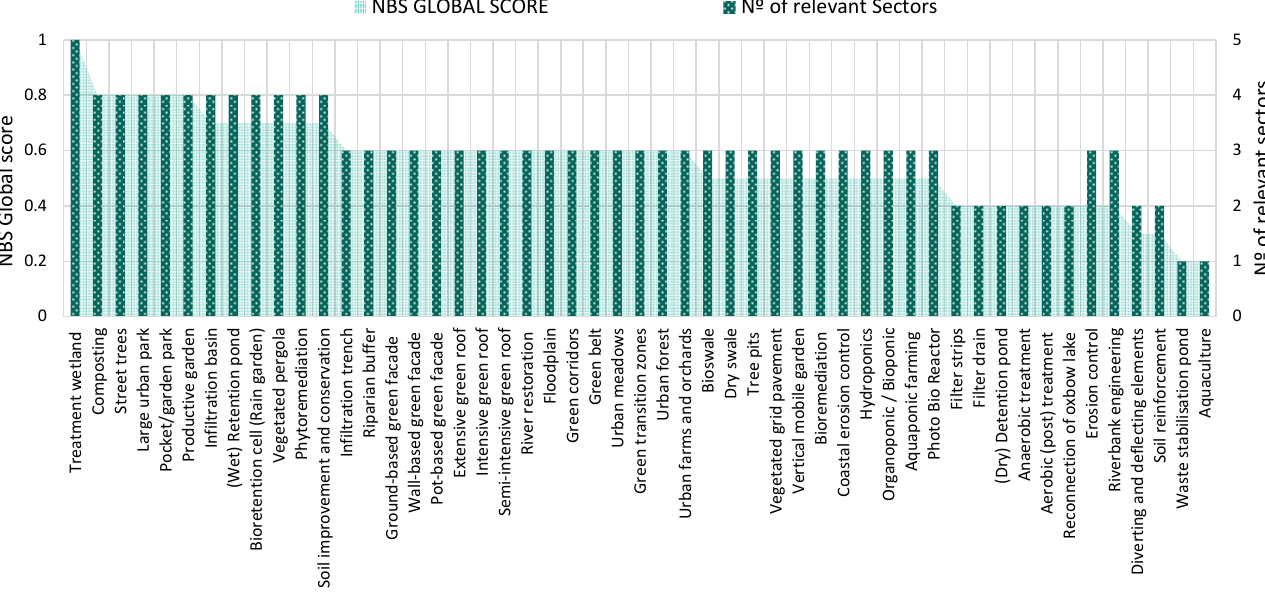
Figure 3. NBS global scores and number of relevant sectors for each unit and intervention (NBS_u/i). The NBS global score describes how many urban sectors selected a specific NBS_u/i as relevant (data from Table 1).